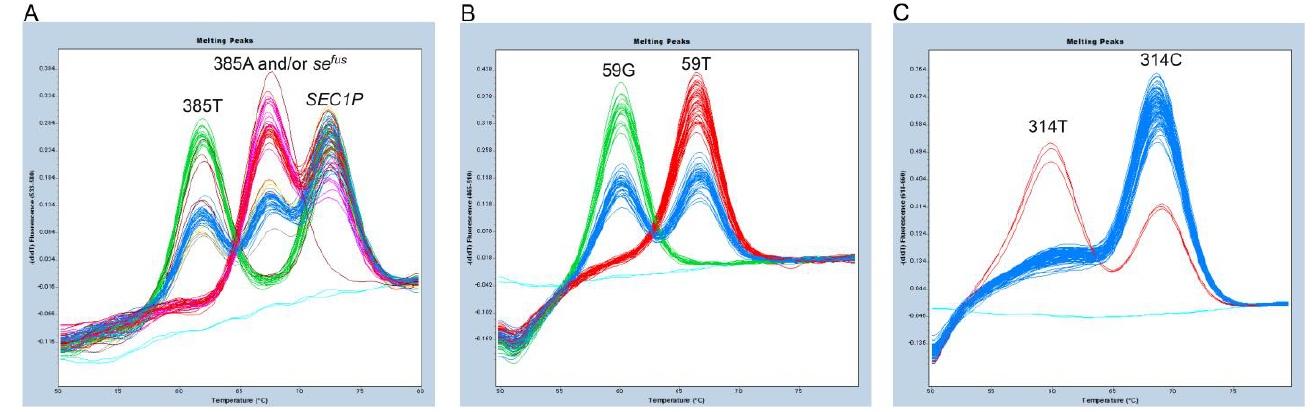
Figure 4. Melting peak profiles of triplex FMCA of 96 Japanese subjects. ( A ) Results for detection of c.385A>T and se fus of FUT2 . The subjects with genotypes between 385A/A and 385A/ se fus and between 385A/T and 385T/ se fus were not completely separated automatically. The unknown group is indicated in brown. Light blue indicates the negative control. ( B ) Results of detection of c.59T>G of FUT3 . The subjects with genotypes of 59T/T are shown in red, those with genotypes of 59T/G in blue, those with genotypes of 59G/G in green. The negative control is shown in light blue. ( C ) Results for detection of c.314C>T of FUT3 . The subjects with genotypes of 314C/C are shown in blue, those with genotypes of 314C/T in red. The negative control is shown in light blue.